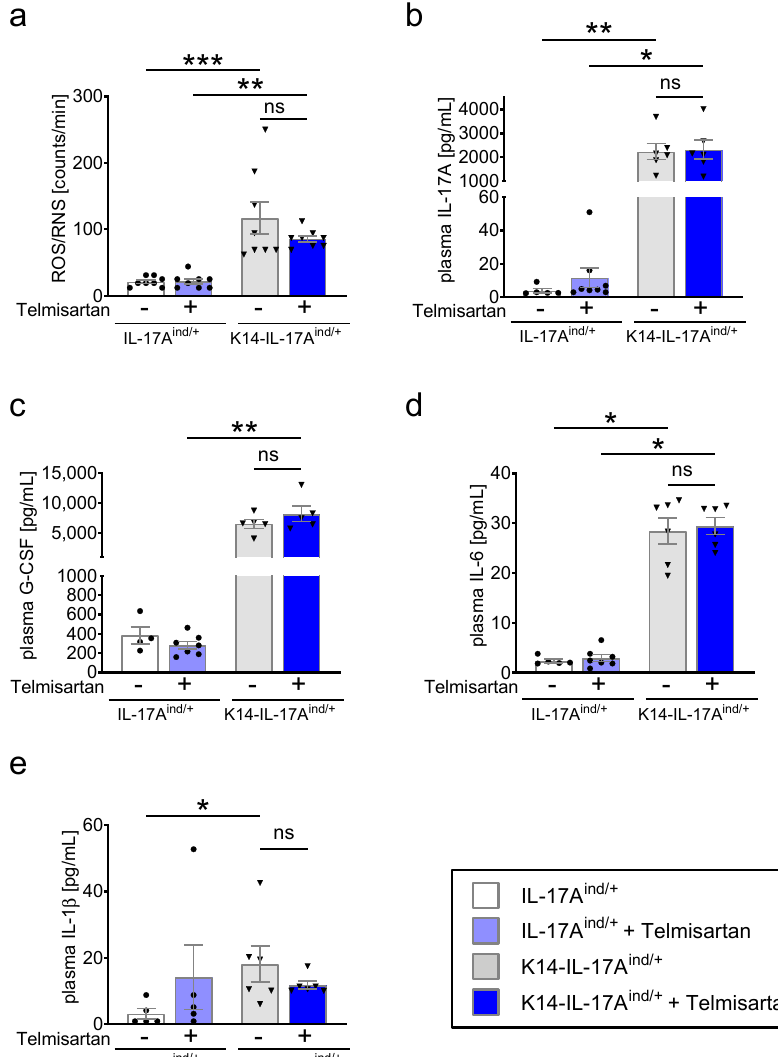
Figure 2. Persistently increased peripheral oxidative stress levels in telmisartan-treated mice suffering from severe psoriasis. ( a ) Reactive oxygen and nitric species (ROS / RNS) measurement of whole blood of K14-IL-17A ind /+ and control mice with and without telmisartan treatment. n = 8, one-way ANOVA with Bonferroni’s post-test. ( b –e) Luminex measurement for b: interleukin (IL)-17A, ( c ): granulocyte-colony stimulating factor (G-CSF), ( d ): IL-6, and ( e ): IL-1 β in plasma of K14-IL-17A ind /+ and control mice with and without telmisartan treatment. n = 5–8, Kruskal–Wallis one-way ANOVA with Dunn’s multiple comparisons test. IL-17A ind /+ mice are presented with black circles and K14-IL-17A ind /+ mice are presented in black triangles. The p-values of ≤ 0.001, ≤ 0.01, and ≤ 0.05 were considered statistically significant and marked by three, two, and one asterisks, respectively, ns = not significant. All data are presented as mean ± SEM.